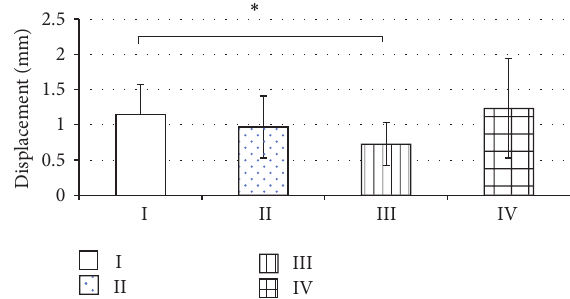
Figure 1: The displacement under cyclic loading (1,000 cycles) was determined for all experimental groups, that is, the locking and nonlocking plates, either in monocortical or bicortical screw fixation. ∗ denotes statistical significance, 𝑃 < 0.05 .